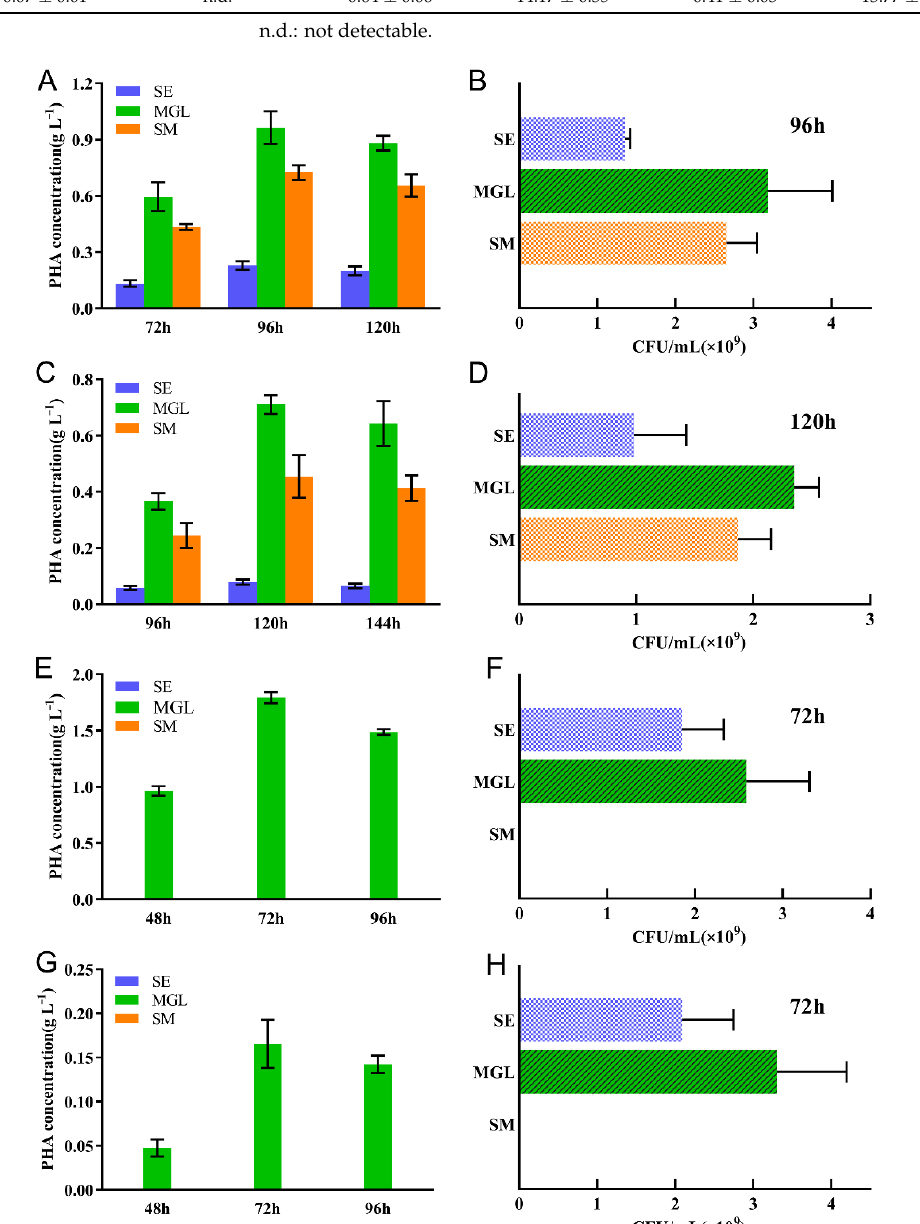
Figure 3. The utilization of the waste silkworm excrement by different strains. The PHA accumulations (( A ) A85, ( C ) A112, ( E ) BSF4, and ( G ) B6)) were detected by a gas chromatography analysis, and the growth conditions of strains A85 ( B ), A112 ( D ), B6 ( F ), and BSF4 ( H ) determined in the SE (blue), MGL (green), and SM mediums (orange) were indicated by CFU counting. All the data are presented as means of duplicates with their standard errors.